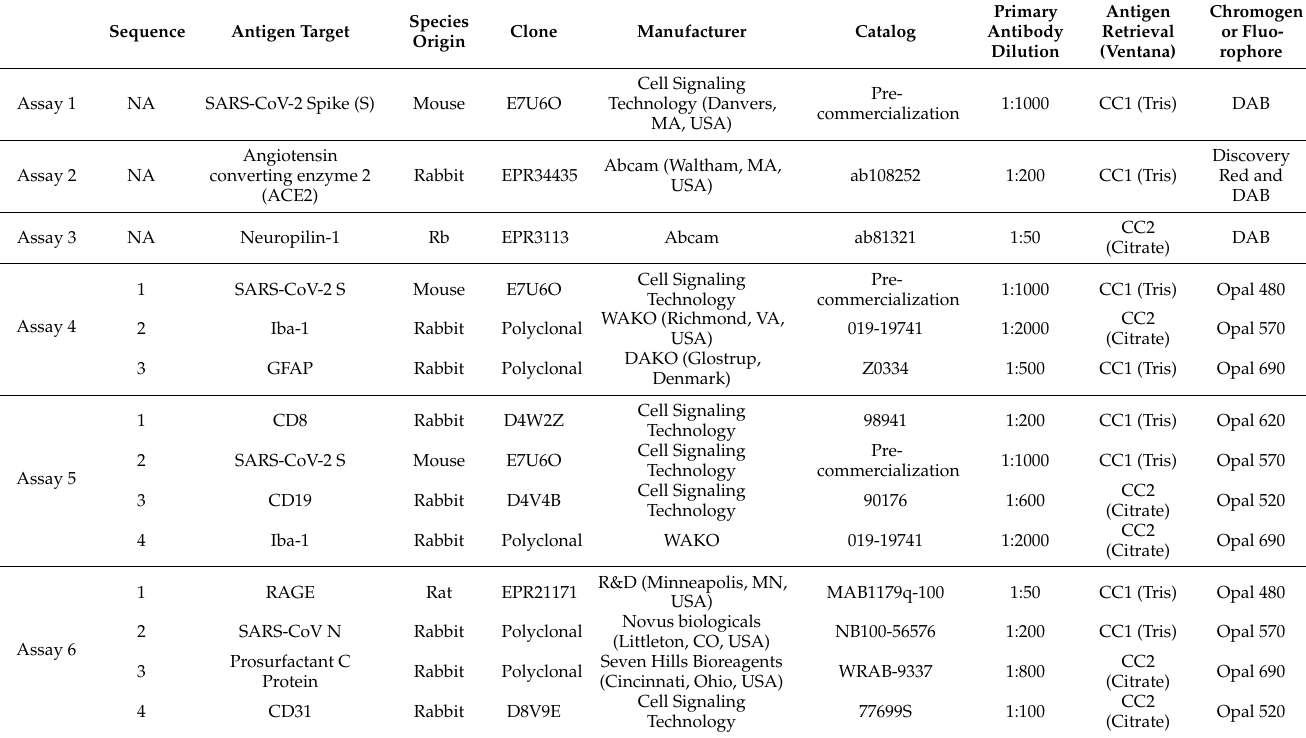
Table 2. Antibodies and antigen retrieval conditions for the assays performed in this